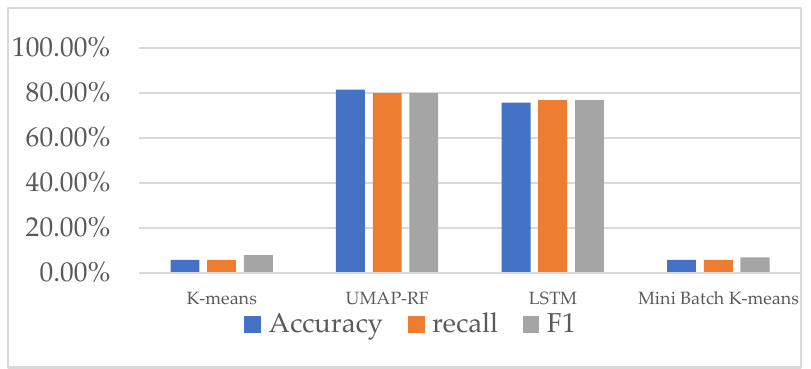
Figure 10. Histogram comparing the results of the multi-classification experiment.